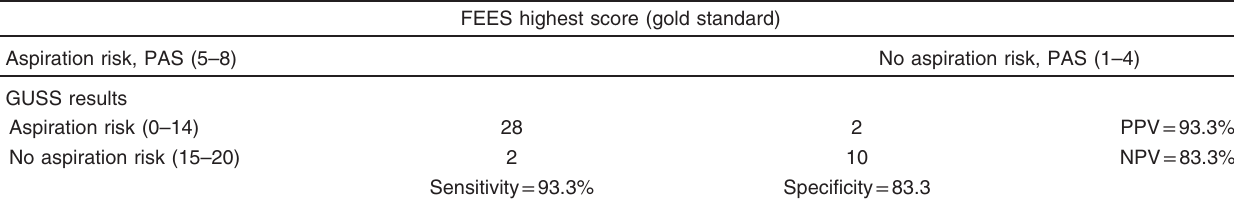
Table 2 Sensitivity, specificity and predictive values of Gugging Swallowing Screening FEES highest score (gold